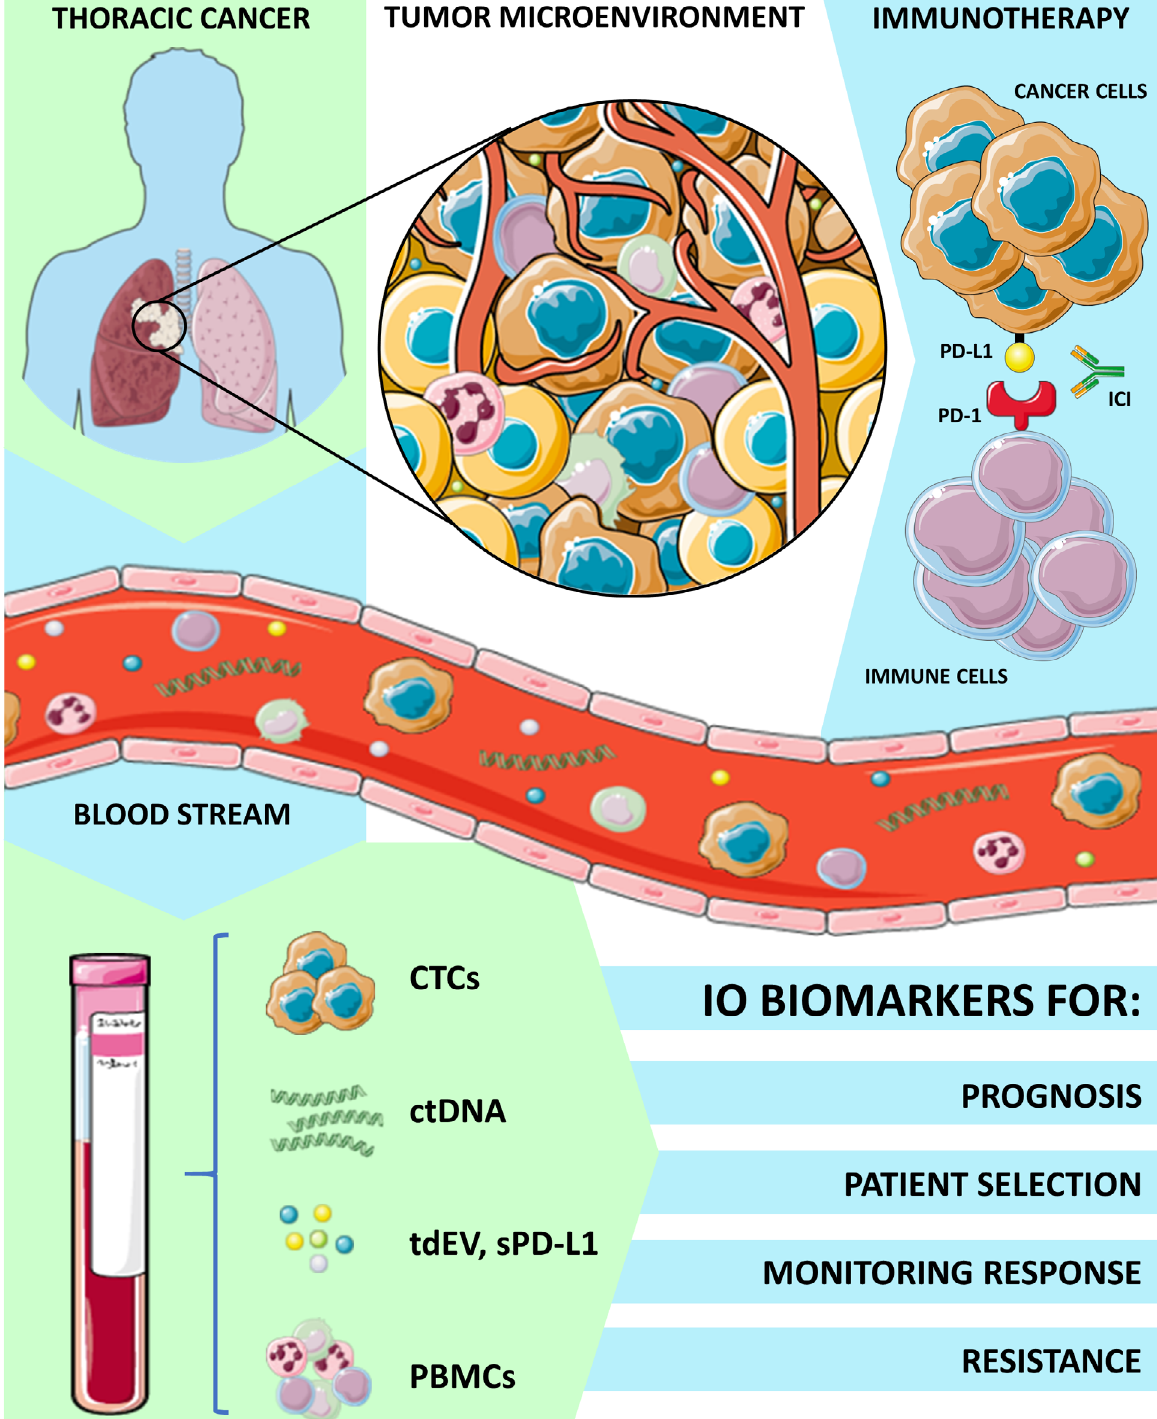
Figure 1 . Applications of LB and circulating biomarkers analysis in thoracic cancers immunotherapy. IO: